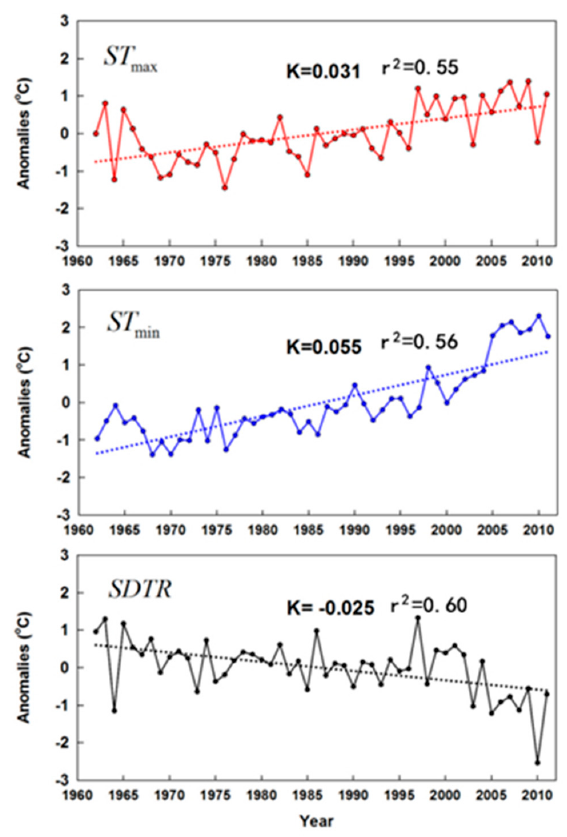
Figure 1. Geographical distribution of the 360 weather stations used in this study.